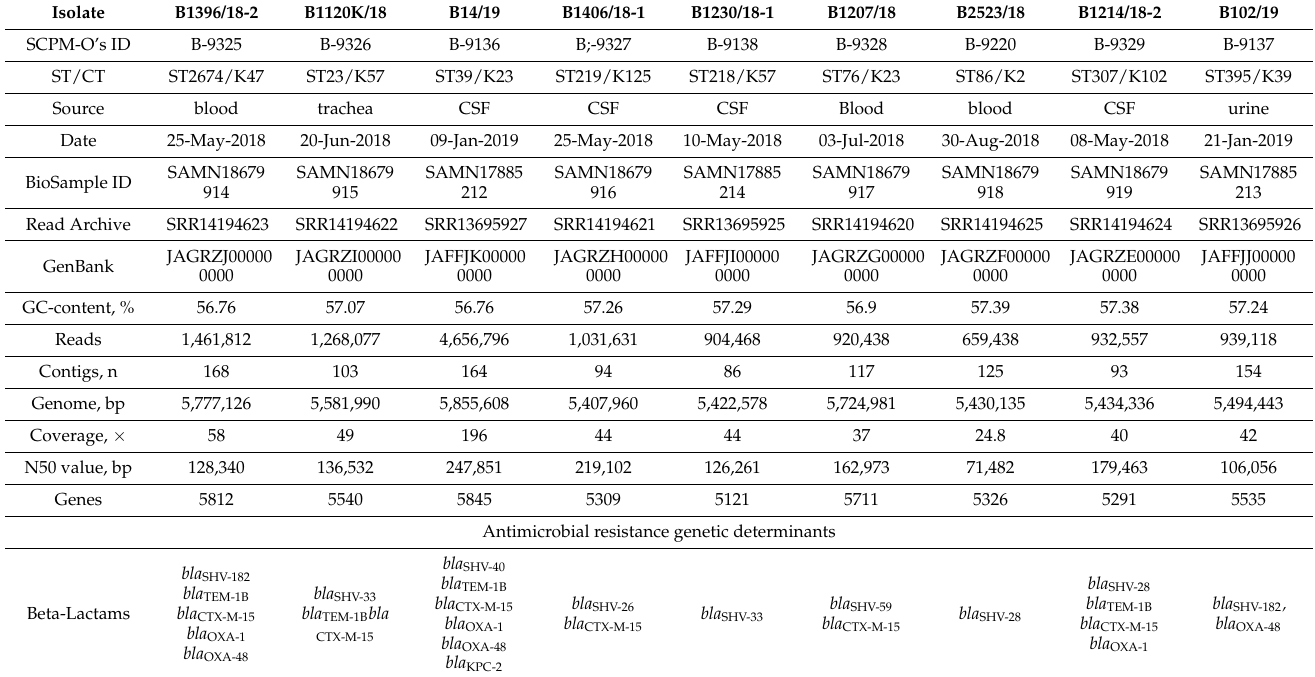
Table 4. Molecular-genetic characteristics of K. pneumoniae isolates based on Whole-Genome